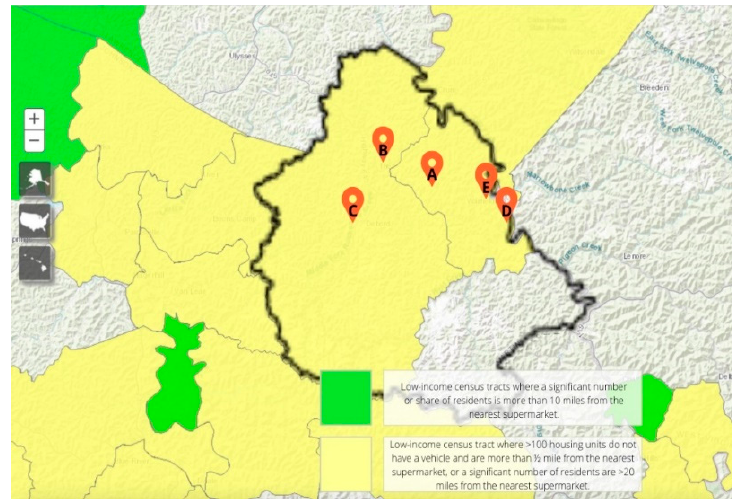
Figure 2. Martin County, KY, USA with designated locations of gas station stores A–E throughout the county.